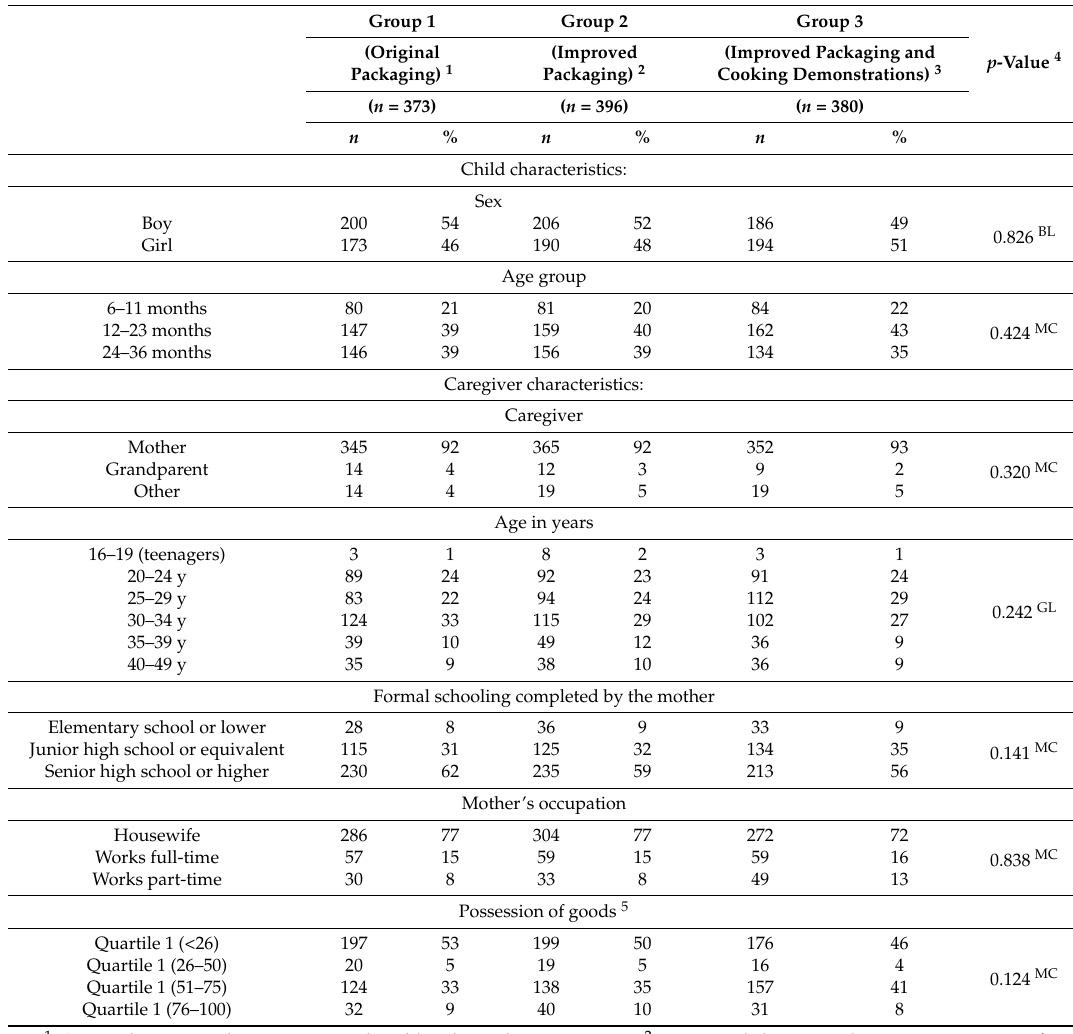
Table 2. Baseline socio-demographic characteristics of study